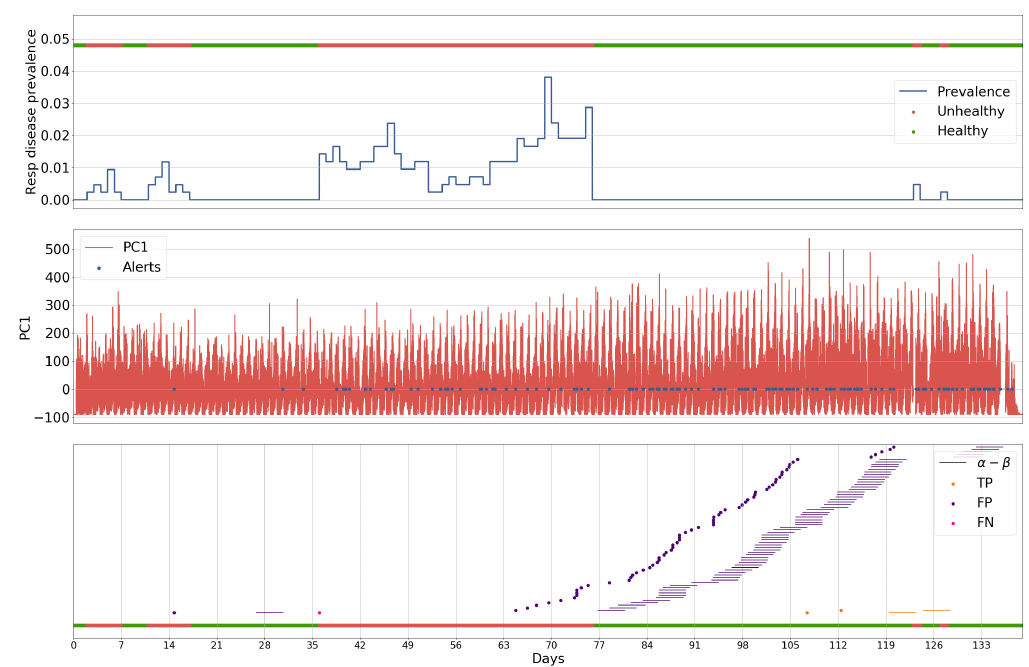
Figure 6. Results for batch 27 processed by the Luminol-powered anomaly detection, given its grid search-optimised parameters α (the start of the window for which an alert is for) and β (the length of the window), in relation to the prevalence of respiratory disease within a single batch.